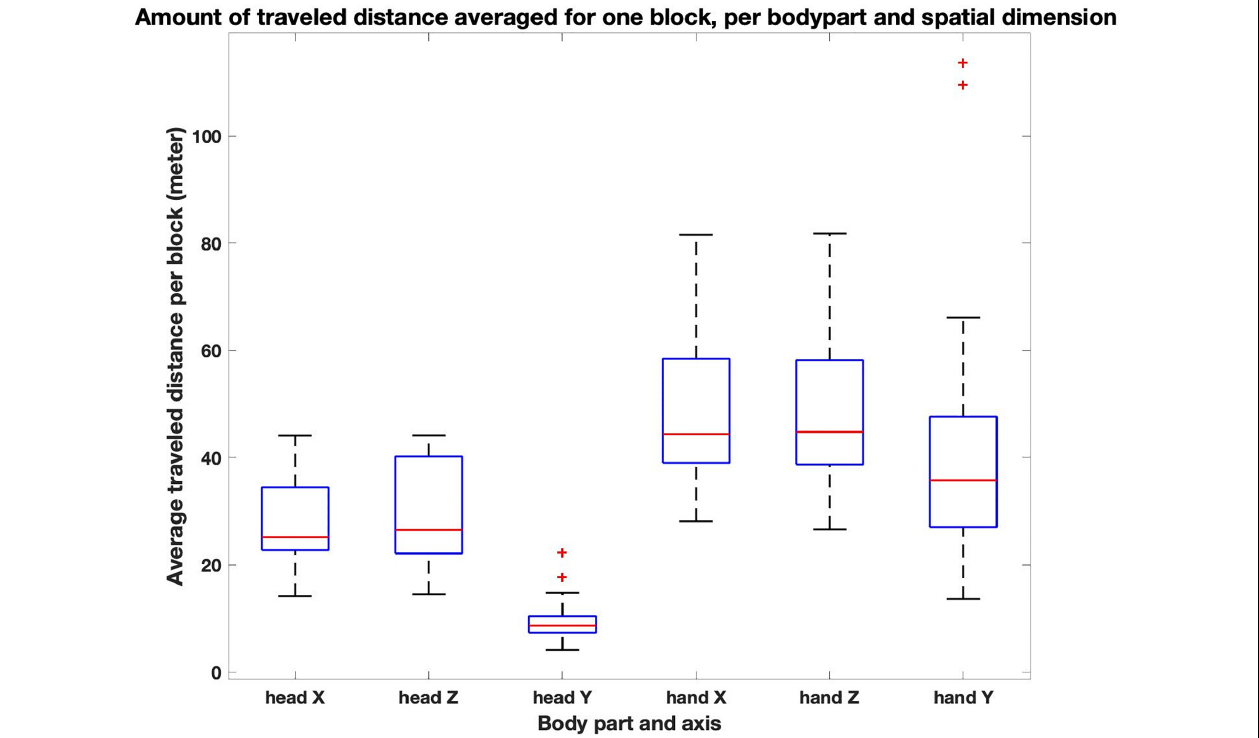
FIGURE 4 | Average amount of distance traveled by block per body part and spatial dimension. In general, distances were quite similar in the X and Z dimension, which reflects the square nature of the virtual space. For the head, displacements along the vertical dimension were significantly smaller than along the horizontal ones (signed-rank Wilcoxon tests; z = 4.11, p < 0.0001). For the hands, displacements along the vertical dimension are also significantly smaller than along the horizontal ones ( z = 2.74 and z = 2.71, p < 0.01 for both vertical vs horizontal comparisons) yet the respective amount of displacements have a comparable